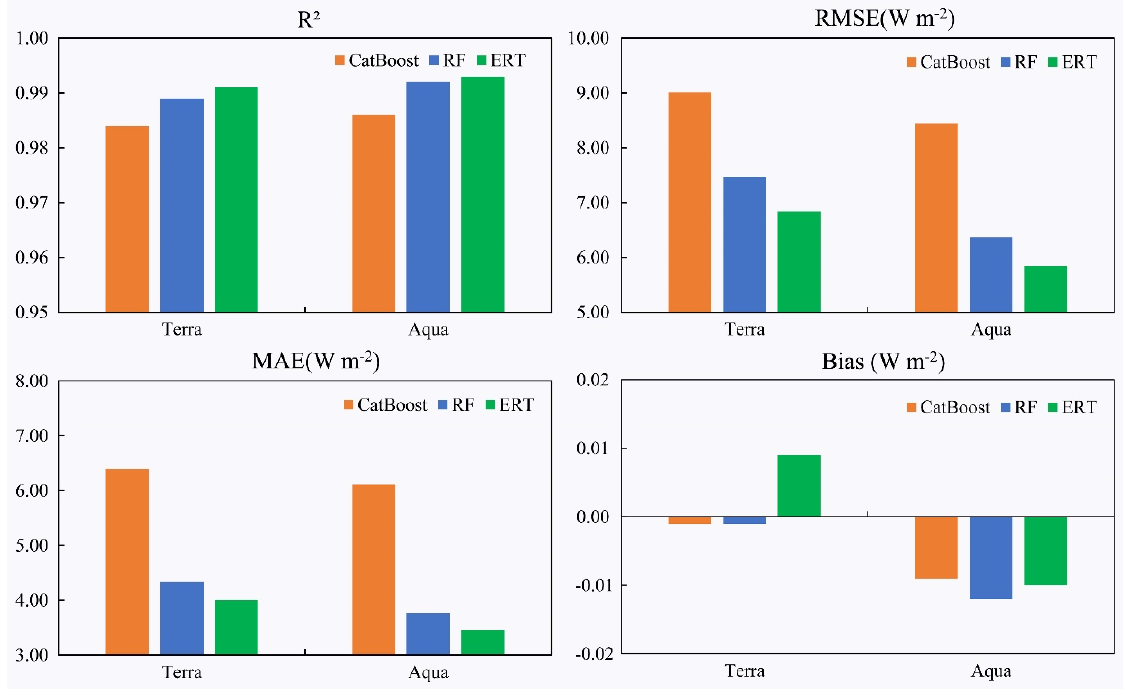
Figure 3. Comparison of the training accuracy metrics of the three ML algorithms using both Terra and Aqua samples.